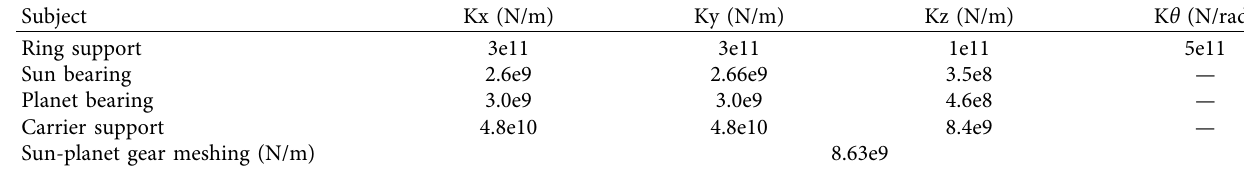
Table 2: Stiffnesses of the